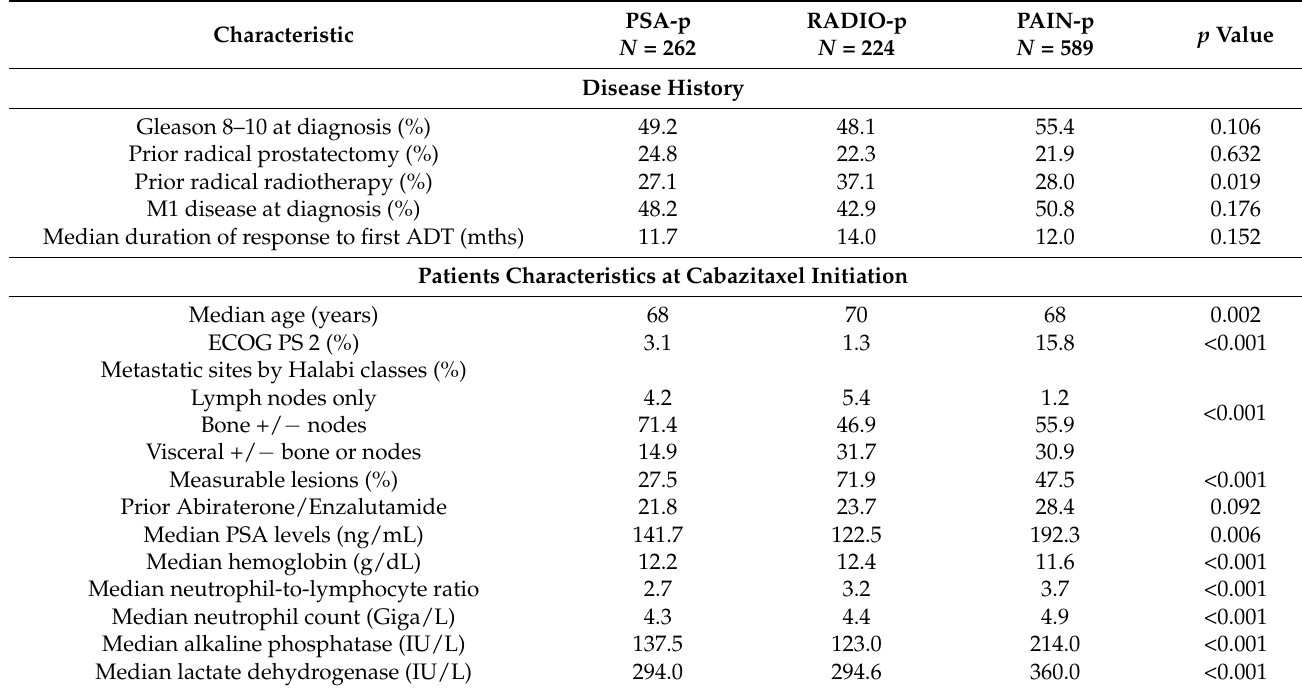
M1 disease at diagnosis (%) Median neutrophil count (Giga/L) Median alkaline phosphatase (IU/L) p -values are global. PSA-p: PSA progression only, RADIO-p: radiological progression (with or without PSA-p), PAIN-p: pain progression with or without PSA-p or RADIO-p, ECOG PS: Eastern Cooperative Oncology Group performance